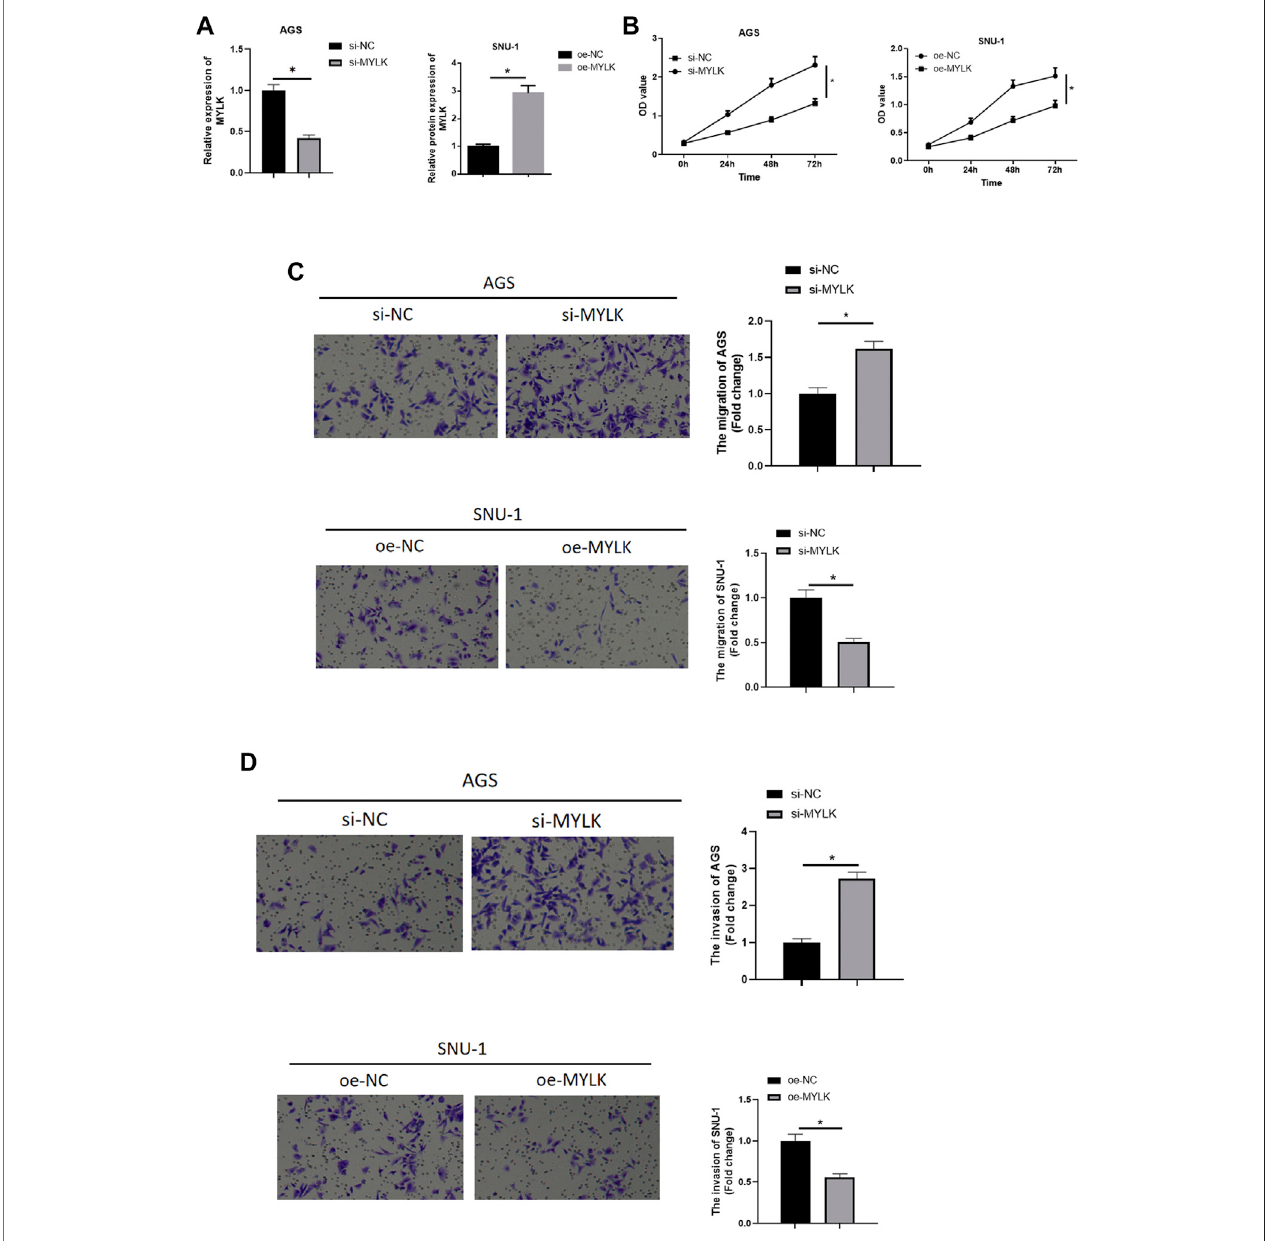
FIGURE4| TheforcedMYLKexpression restrainsGCcellmalignant progression,withtheoppositeeffectbyknockingdown MYLK. (A) qRT-PCRassayedMYLK mRNA expression in AGS and SNU-1 cells with varying treatments; CCK-8 and Transwell assays (100 × ) were performed to measure (B) cell viability, (C) cell migration and (D) invasion of AGS and SNU-1 cells; * p <